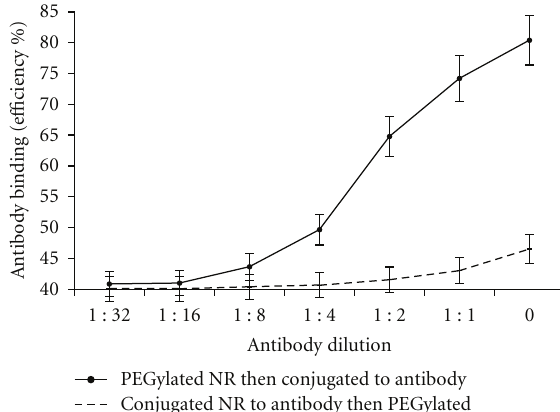
Figure 3: A comparative antibody binding assay based on the sequential order of conjugation and PEGylation, summarizing the binding e ffi ciency of antibodies when conjugated to nanorods then PEGylated (solid line) and antibodies conjugated to PEGylated nanorods (dashed